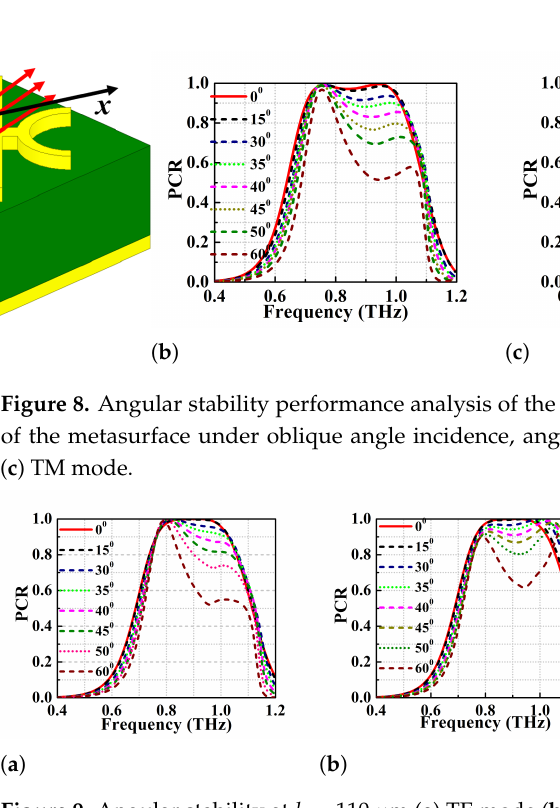
Figure 9. Angular stability at l 1 = 110 µ m ( a ) TE mode ( b ) TM mode.